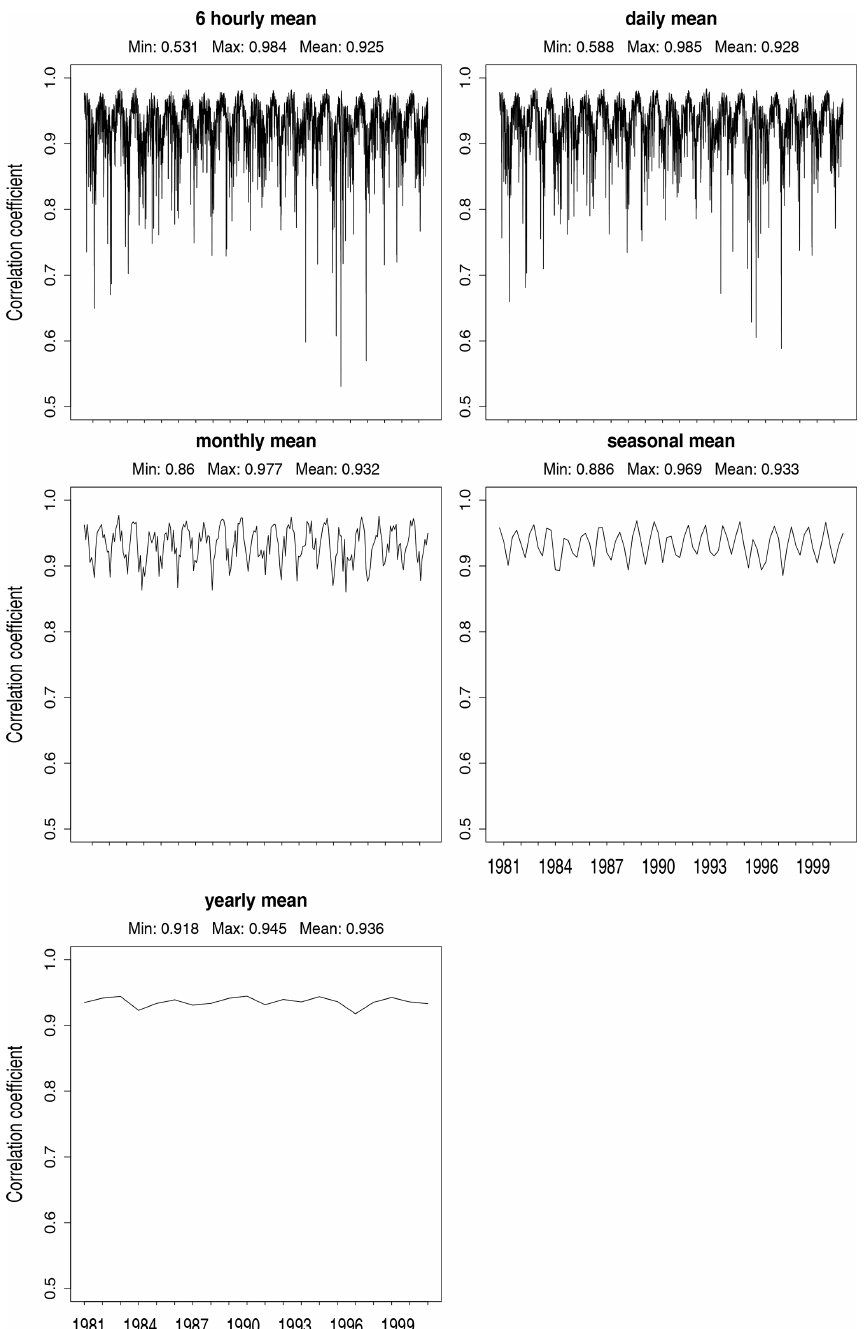
Figure 13. Spatial correlation coefficient of geopotential at 500hPa between ICLM-REF and ERA-Interim data for various temporal scales: 6-hourly, daily, monthly, seasonal and yearly. Data were taken in the period